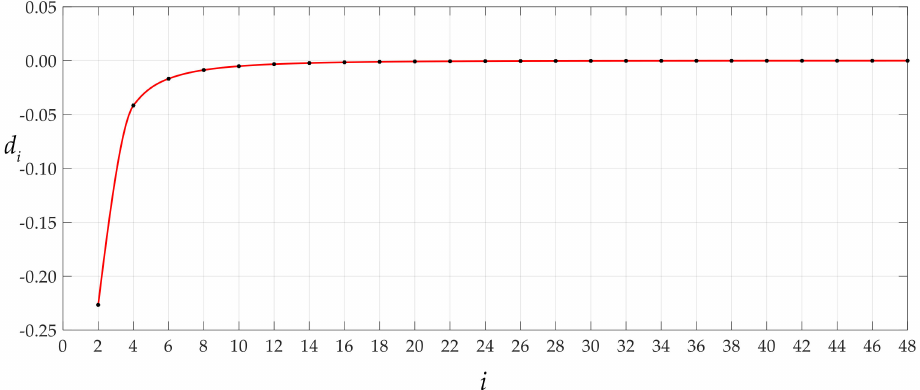
Figure 6. Variations of d i with i when q = 0.003 MPa, c 0 = 0.147769 and d 0 =